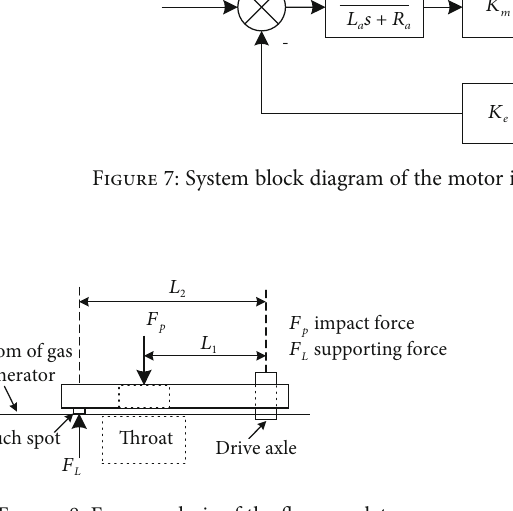
Figure 8: Force analysis of the fl ow regulator.